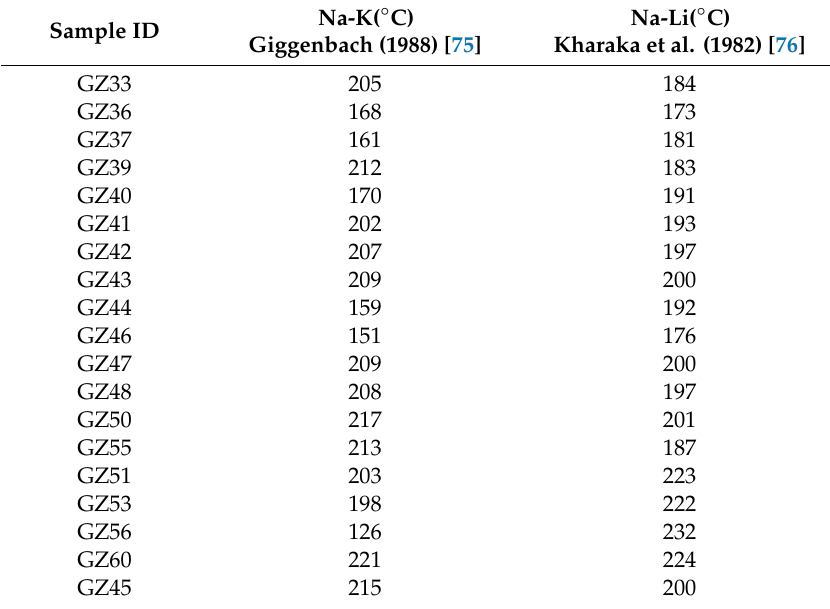
Table 3. Chemical geothermometry estimates of reservoir